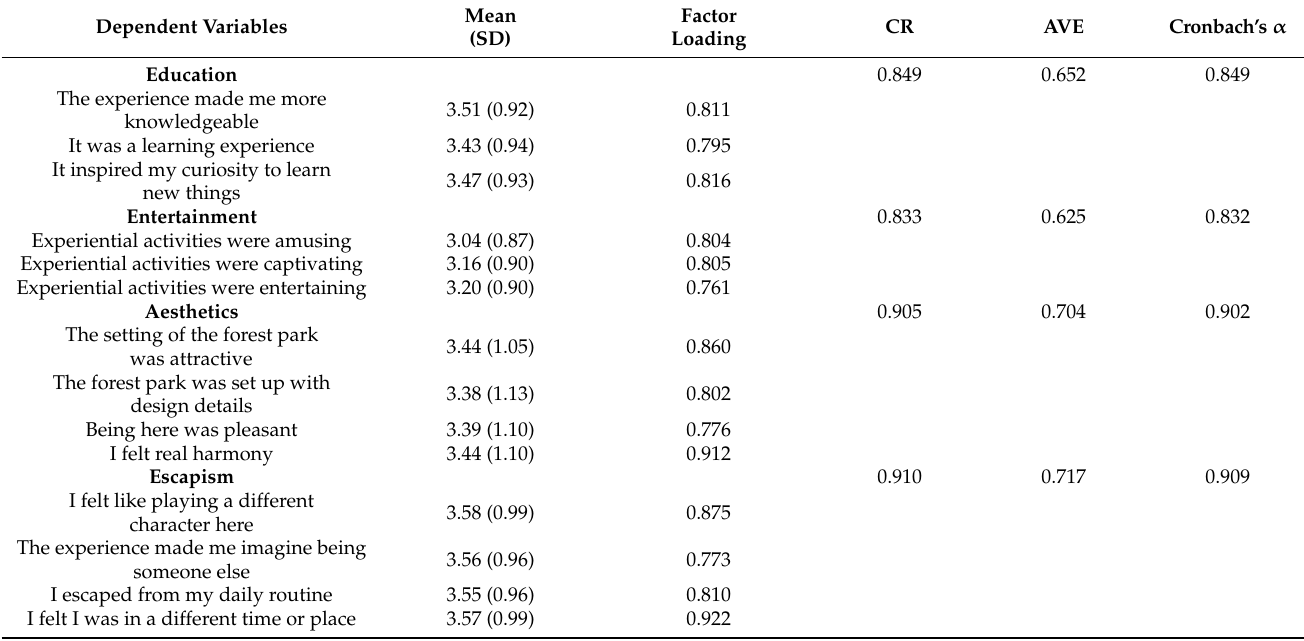
Table 2. Reliability and confirmatory factor analysis